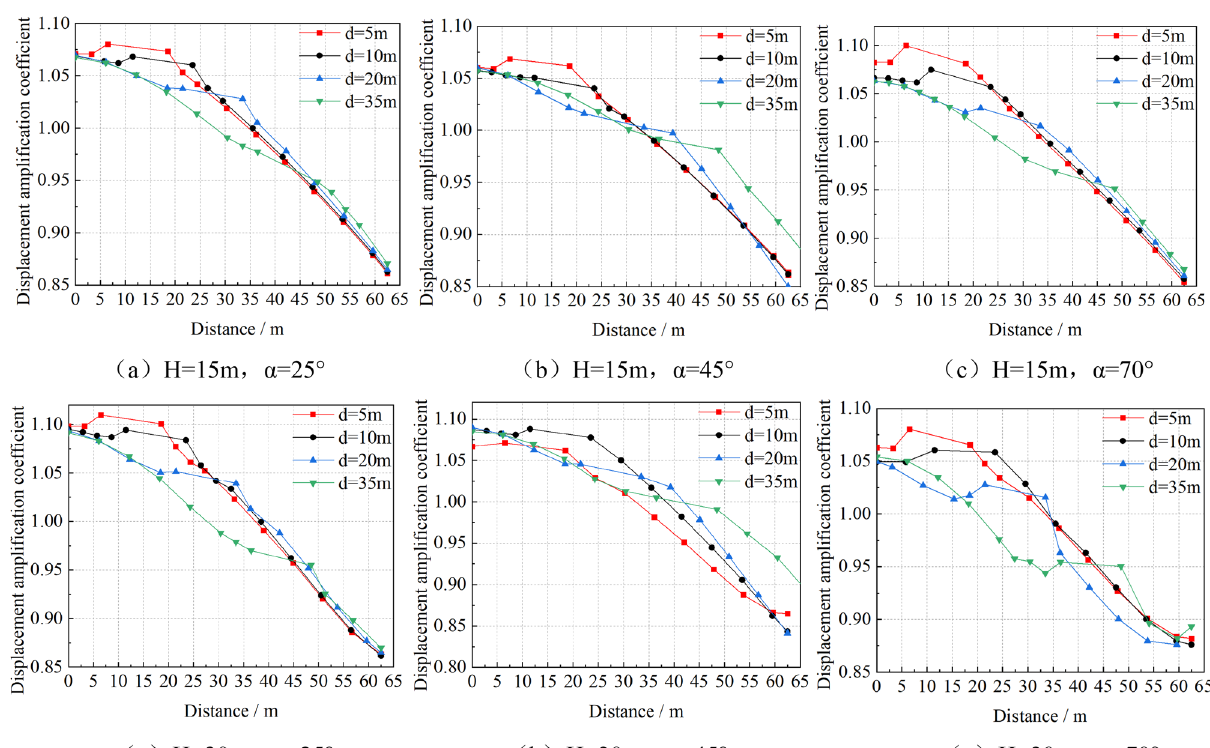
Figure 11. Displacement amplification coefficient of top slope VS distance from slope